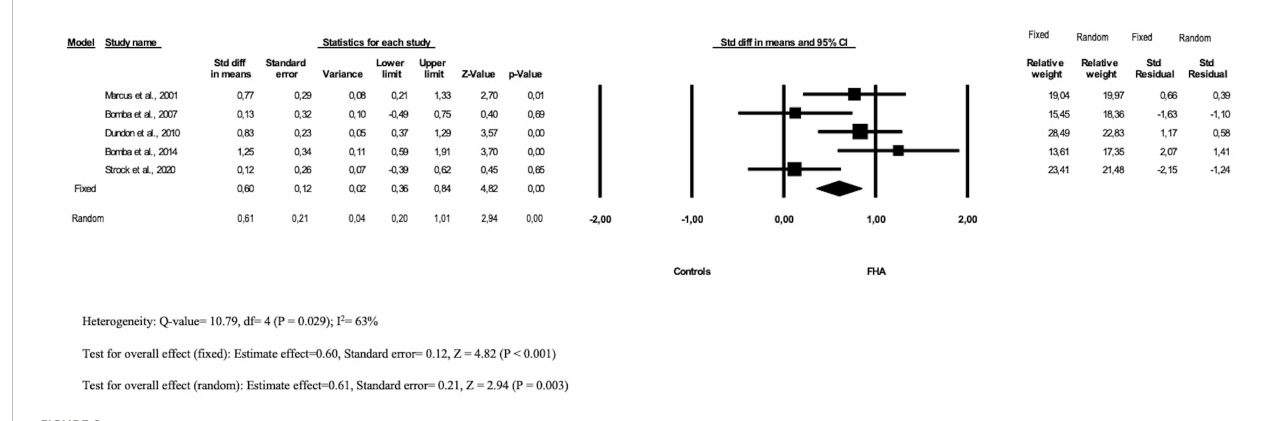
FIGURE 2 Forest plot of depression prevalence in FHA patients and controls.